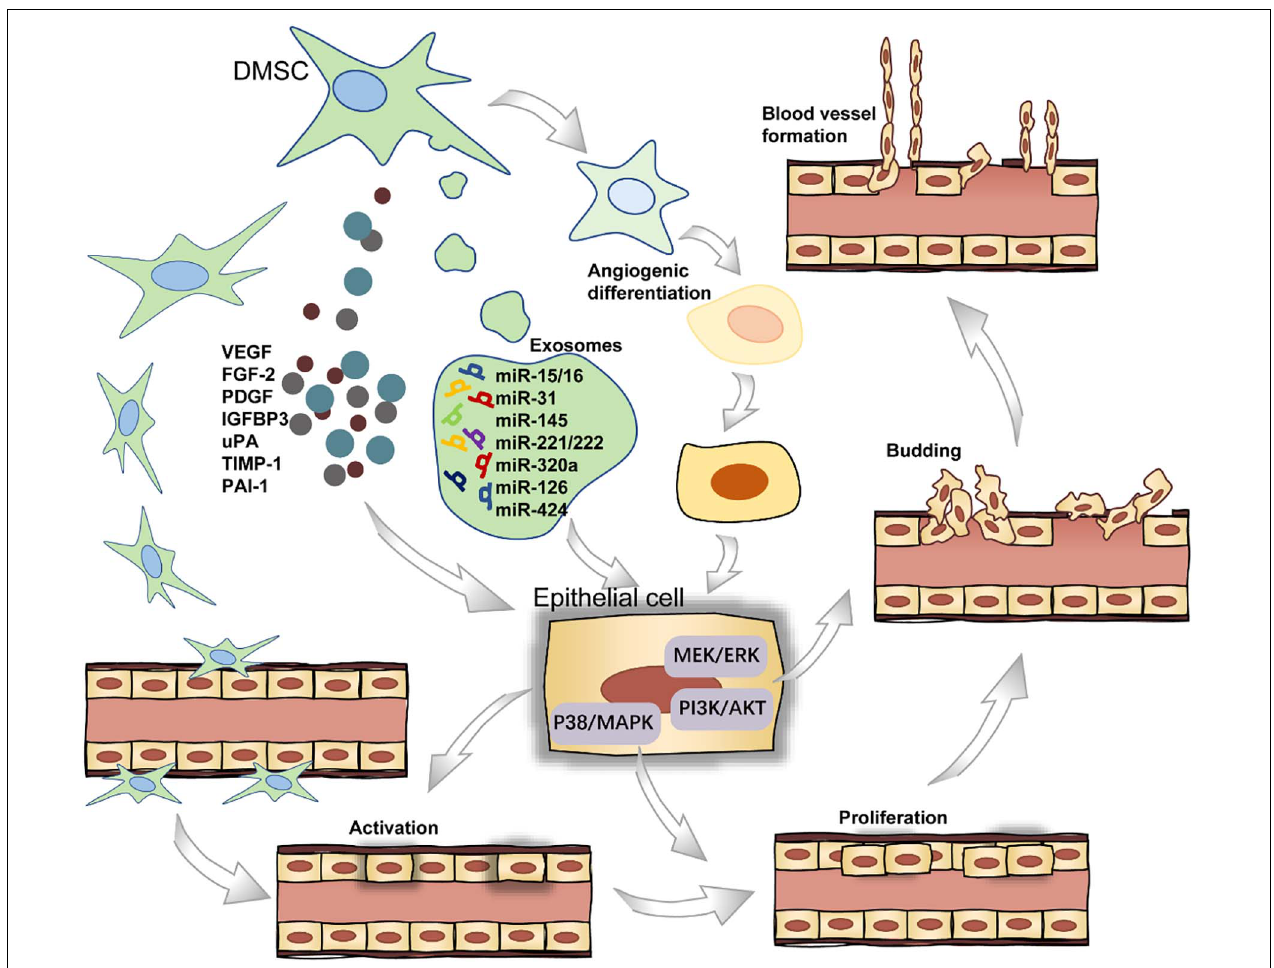
FIGURE 3 | The role of DMSCs in blood vessel formation.